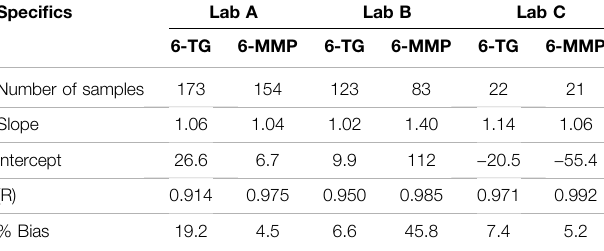
TABLE 1 | Summary of the results of method